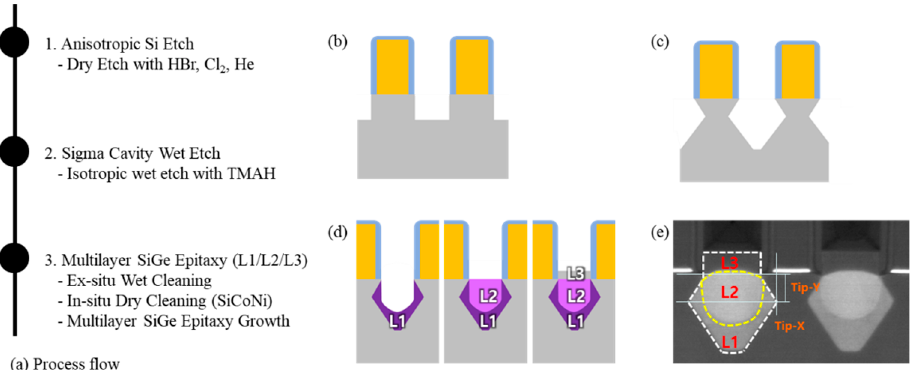
Figure 1. ( a ) The process flow and schematic structure at each step. ( b ) Anisotropic Si etch through dry etching using HBr, Cl 2 , He. ( c ) The sigma-shaped cavity was formed through wet etching. ( d ) Multilayer SiGe epitaxial growth. ( e ) Cross-sectional TEM image after SiGe growth.